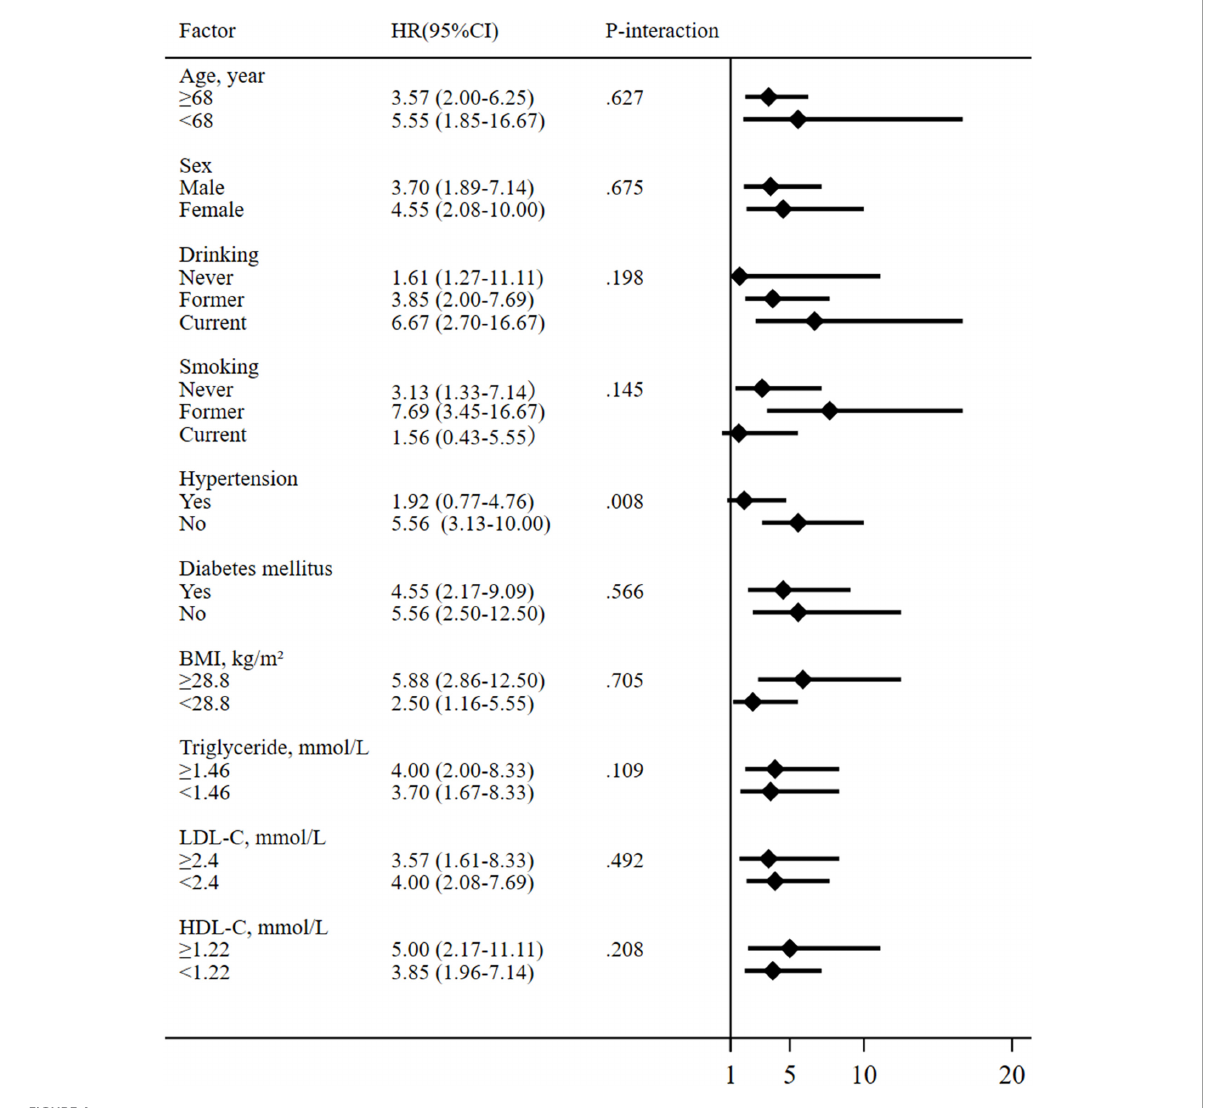
FIGURE4 Subgroup analysis for the association between albumin levels and cardiovascular disease (CVD) mortality. Continuous variables were dichotomized at their corresponding medians. All models are adjusted as in Table 2